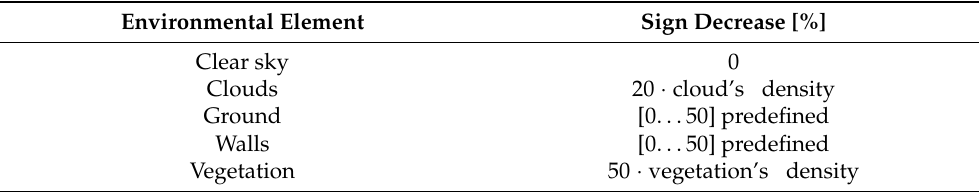
Table 1. Background impacts on the signal.